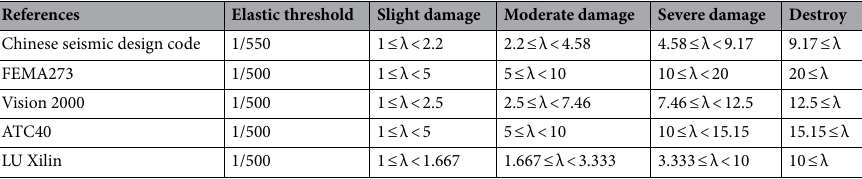
Table 2. Structural damage factor interval for different damage states.